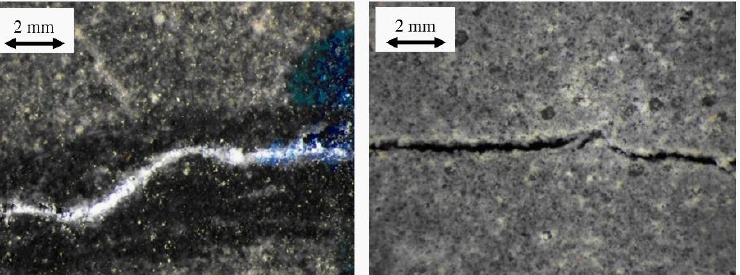
Figure 7. Decrease in the normalized flow rate because of the self-healing of the crack at various temperatures, a pressure gradient of 1 MPa/m, and a crack width of 0.05 mm. Reprint with the permission from ref. [61]. Copyright 2022 Elsevier.